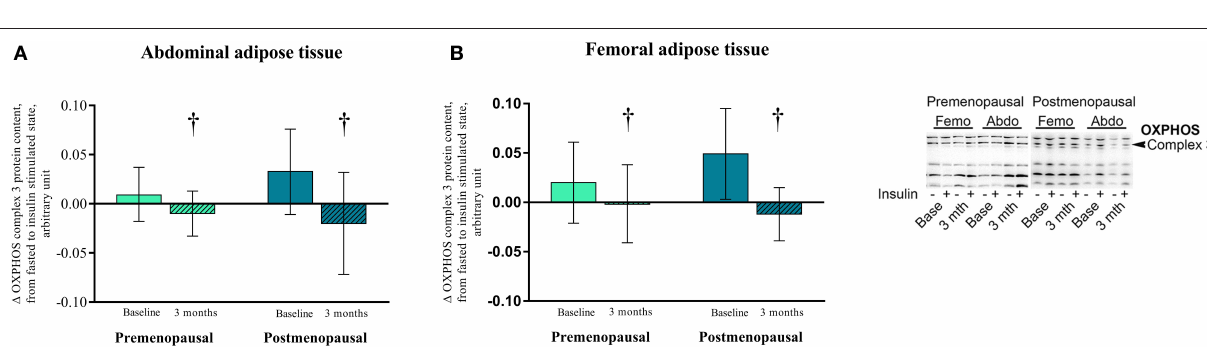
FIGURE 7 | Abundance of proteins associated with mitochondria in abdominal and femoral subcutaneous adipose tissue in pre- and post-menopausal woman before and after 3 months of high-intensity training. Abundance of OXPHOS complex 1 was higher in abdominal compared to femoral adipose tissue in post-menopausal women. Abdominal OXPHOS complex 5 content increased after the training intervention in post- but not in pre-menopausal women. Difference between abdominal and femoral depots ‡ p ≤ 0.05. Interaction between groups and time # p ≤ 0.05. Changes from baseline to 3 months † p ≤ 0.05. Data are presented as median (25–75 percentile). CS, Citrate synthase.